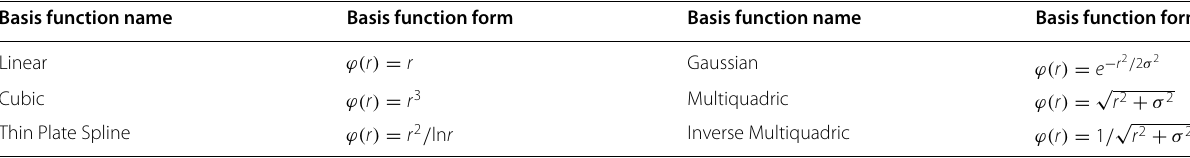
Table 1 Basis functions of RBF Basis function name Basis function form Basis function